Question: Write the caption for this figure.
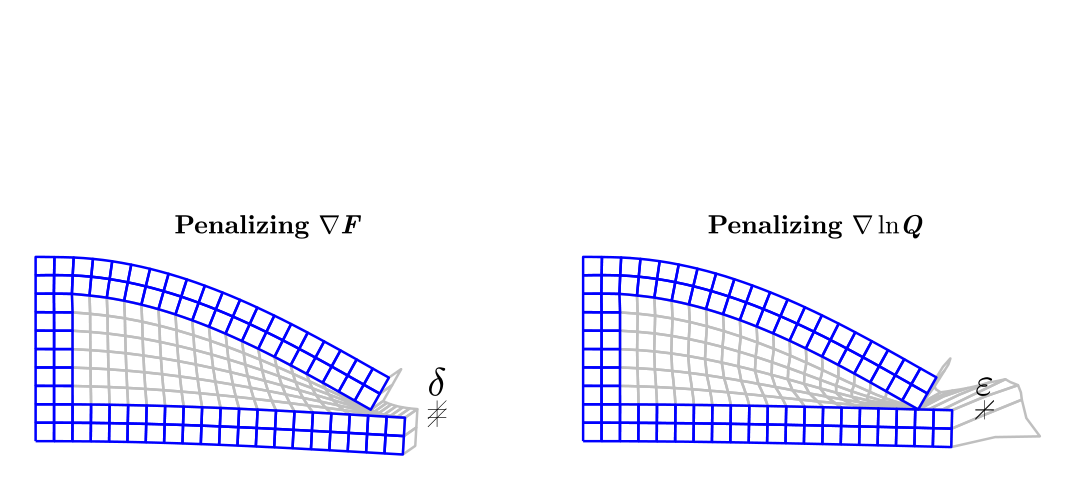
Answer: Comparison of the effect of regularization terms ∇F and ∇ln Q. The regularization based on rotation (∇ln Q) leads, for the same material parameters, to a lower stiffness of the third medium and hence smaller contact gap (ε << δ).